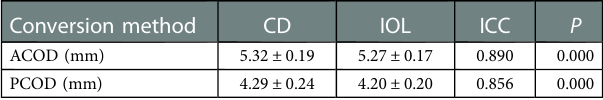
TABLE 2 Intraclass correlation coef fi cient between the values of ACOD and PCOD converted by CD and